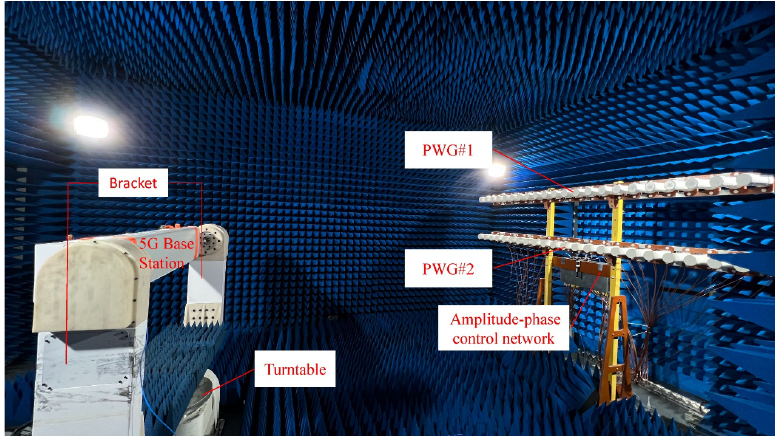
Figure 16. Base station antenna pattern test system.